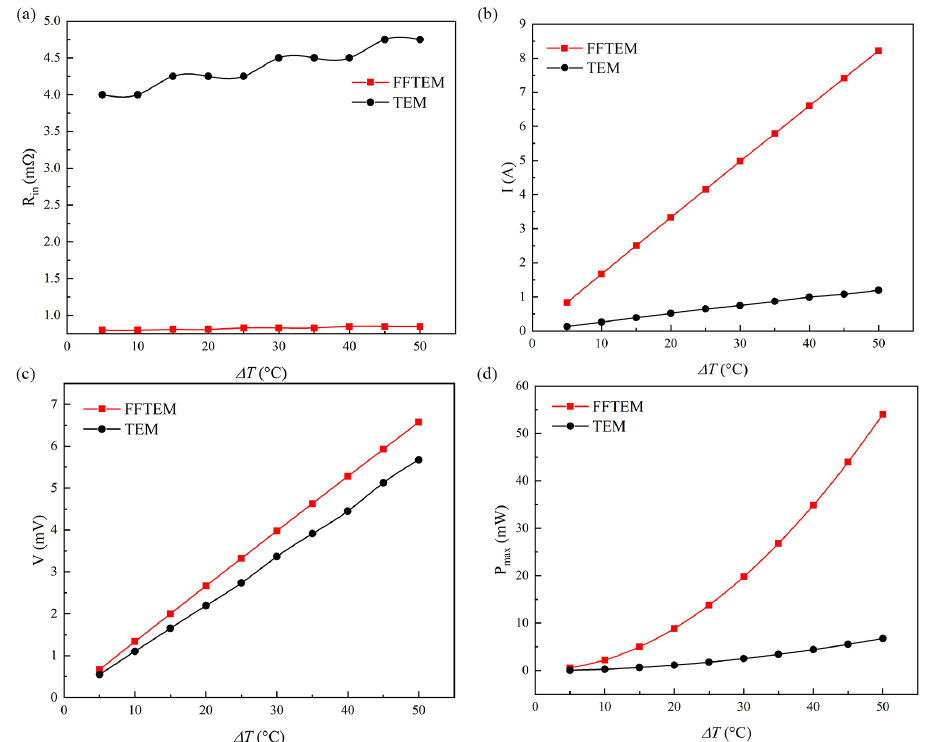
Figure 6. ( a ) The inner resistance, ( b ) output voltage, ( c ) working current, and ( d ) maximum output power for the FFTEM and TEM models as a function of ∆ T at a matched load condition.